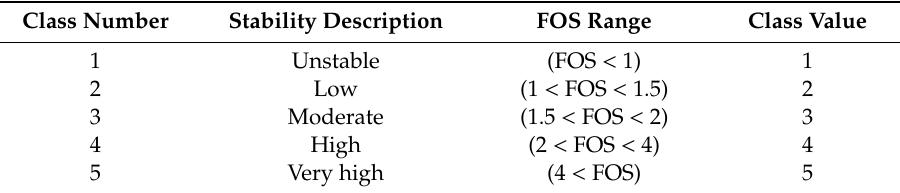
Table 2. Description of stability